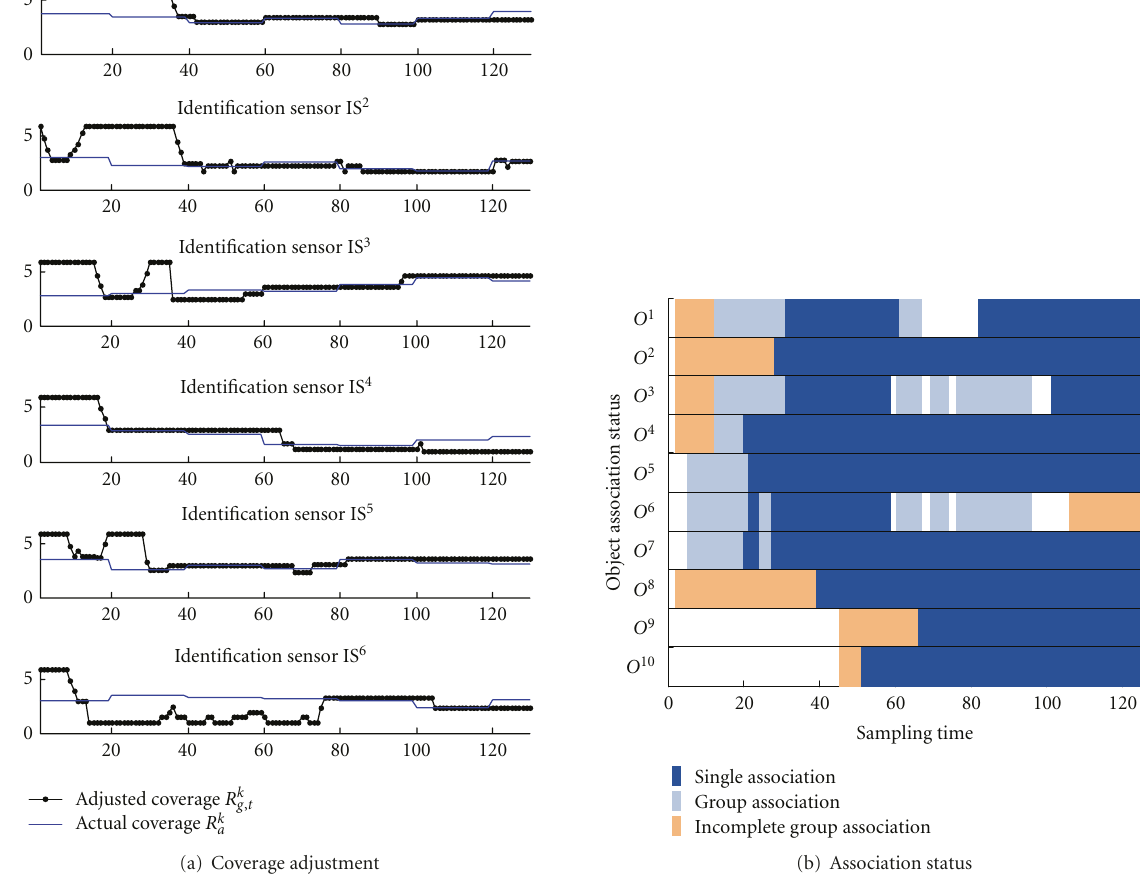
Figure 15: Simulation result of coverage adjustment and association status.